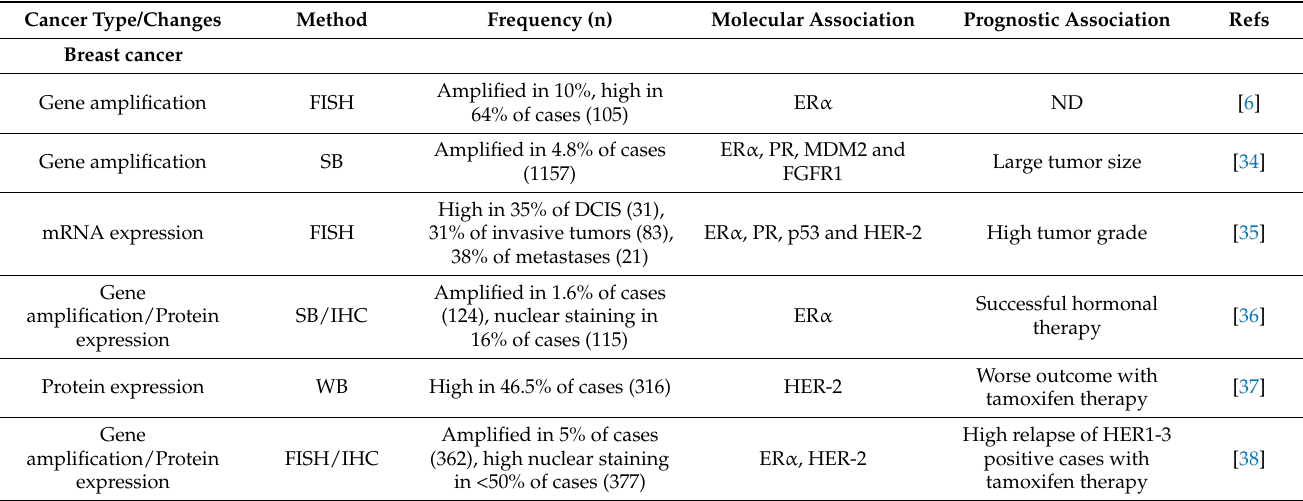
Table 1. Gene amplification and expression of SRC-3 in cancer and clinical